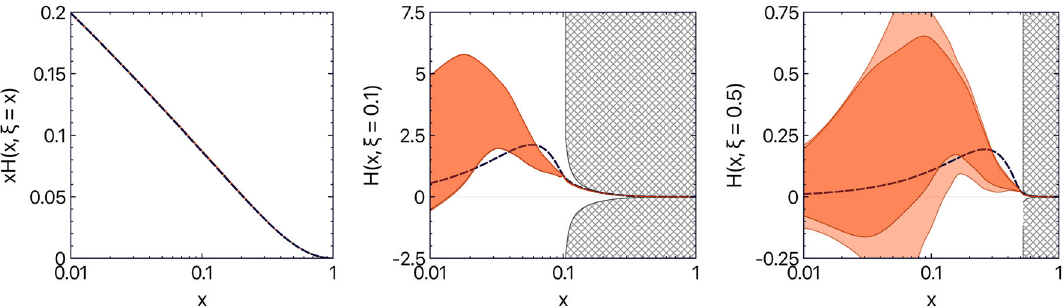
Fig. 8 Result of constraining the ANN model using 200 points evalu- ated with the GK model [25–27] for sea quarks: x = ξ case, positivity enforced, F D (β,α) not shown. See the text for more details. The com- parison is for (left) x = ξ , (center) ξ = 0 . 1 and (right) ξ = 0 . 5. The dashed lines denote the GK model, while the bands represent